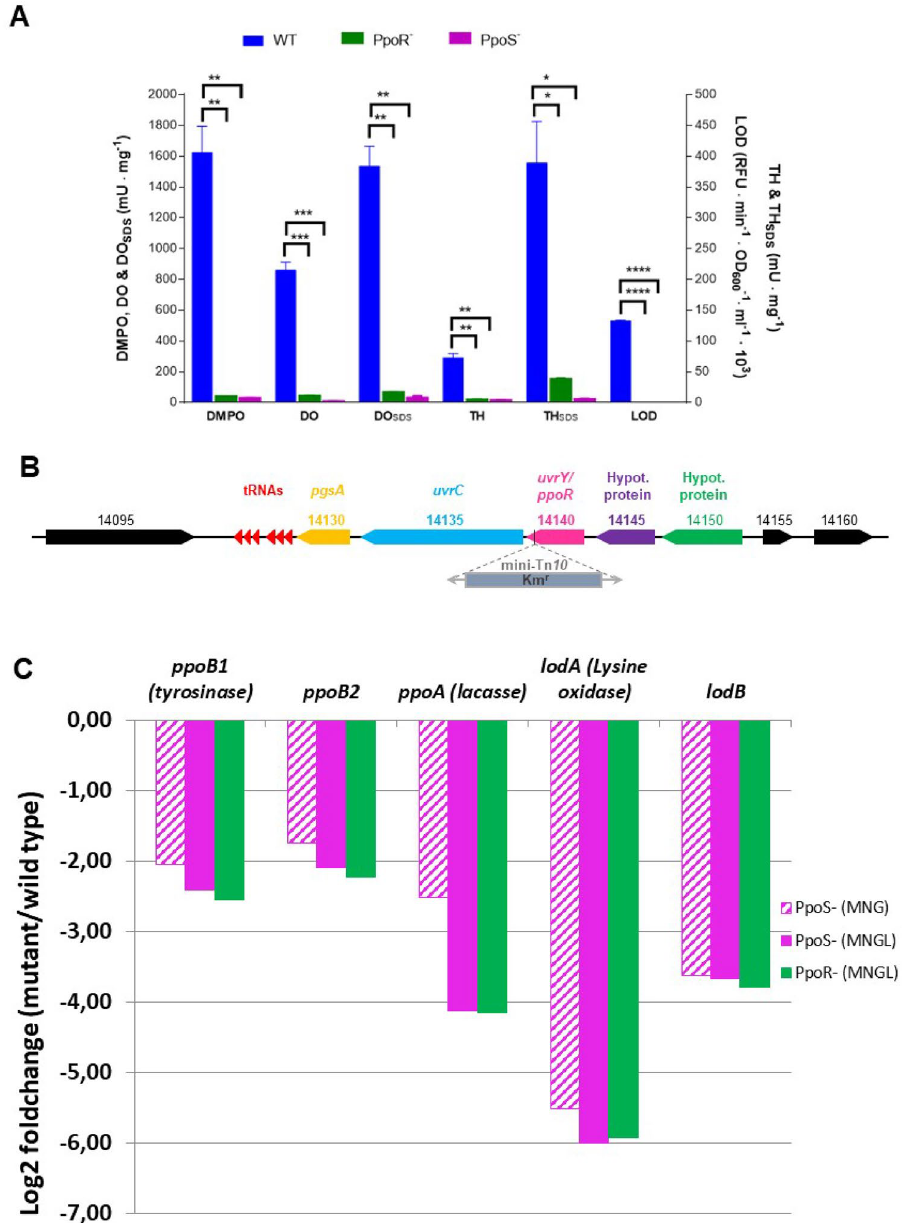
Figure 1. Identification of the response regulator PpoR. ( A ) Oxidase activities in Marinomonas mediterranea strains: DMPO (Dimethoxyphenol oxidase, characteristic of laccase), DO (L-dopa oxidase), TH (Tyrosine hydroxylase) and LOD (ε-lysine oxidase). The subscript SDS indicates activity in the presence of SDS which is characteristic of the tyrosinase. Blue bars, wild type strain (MMB-1R); green bars stand for strain PpoR − ; and magenta bars for strain PpoS − . Error bars represent means ± s.d, (n = 2). * P < 0.05; ** P < 0.01. *** P < 0.001, **** P < 0.0001 according to one-way ANOVA followed by Tukey’s post test. ( B ) Genomic region surrounding the site of insertion of the transposon in strain T102. Marme_RS14095, MARME_RS14145 and MARME_ RS14150 encode hypothetical proteins. MARME_RS14130 encodes a CDP-diacylglycerol glycerol-3-phosphate 3-phosphatidyltransferase (PgsA). MARME_RS14135 shows similarity to uvrC . ( C ) PpoR and PpoS mutations show a very similar effect on the transcriptomic regulation in MNGL and MNG media, determined by RNA- Seq, of the oxidase genes in M. mediterranea : ppoB1 (tyrosinase), ppoB2 (copper chaperone), ppoA (laccase), lodA (ε-lysine oxidase), lodB (flavoprotein post-transcriptionally processing